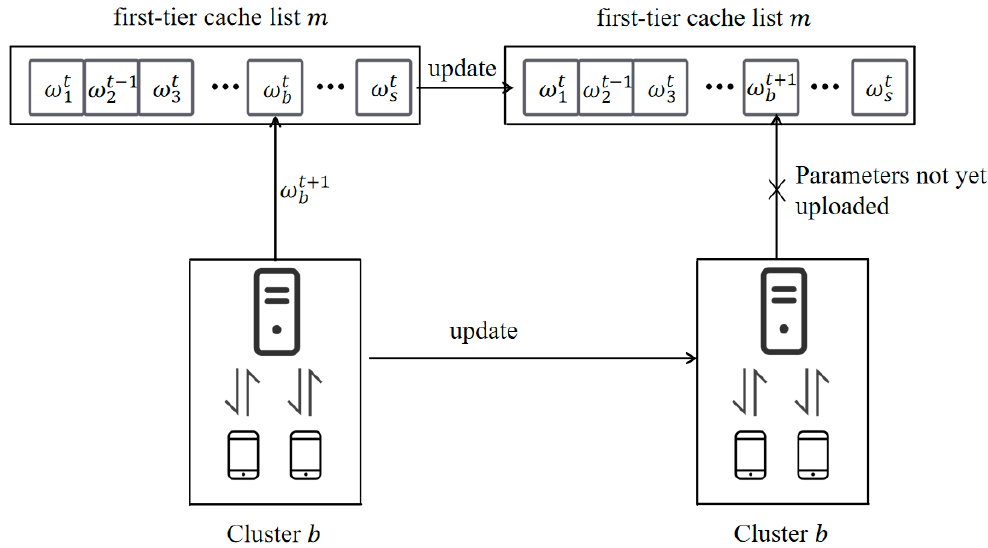
Figure 2. Update principle of the fi rst-tier cache.